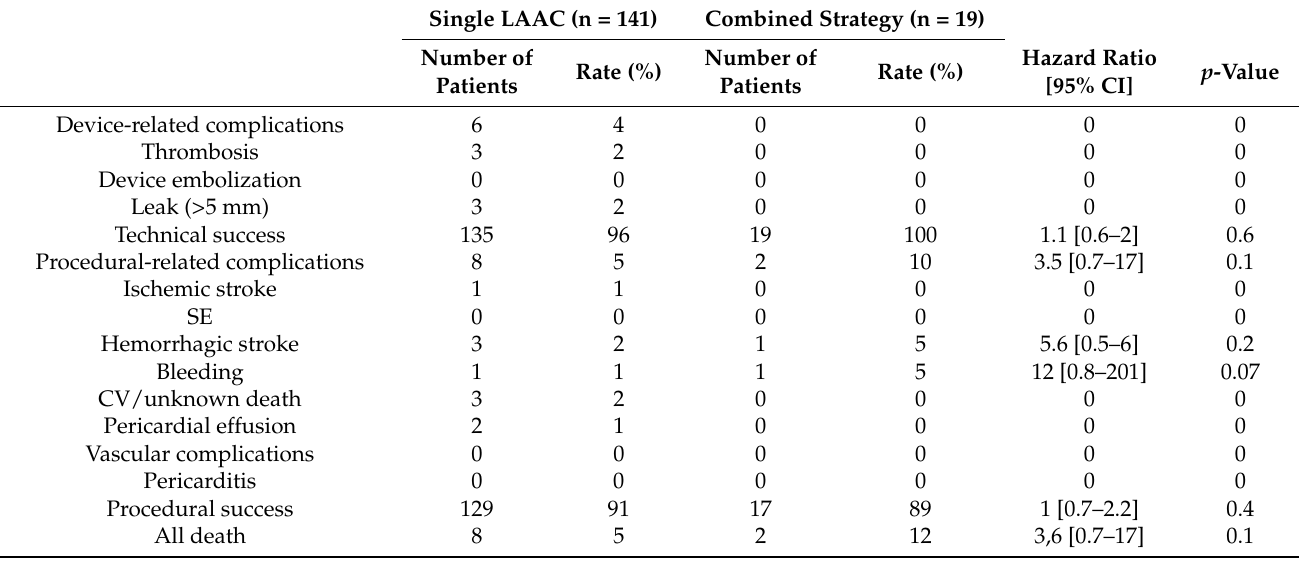
Table 4. Midterm Outcomes in Single LAAC Procedures and Combined Strategy.